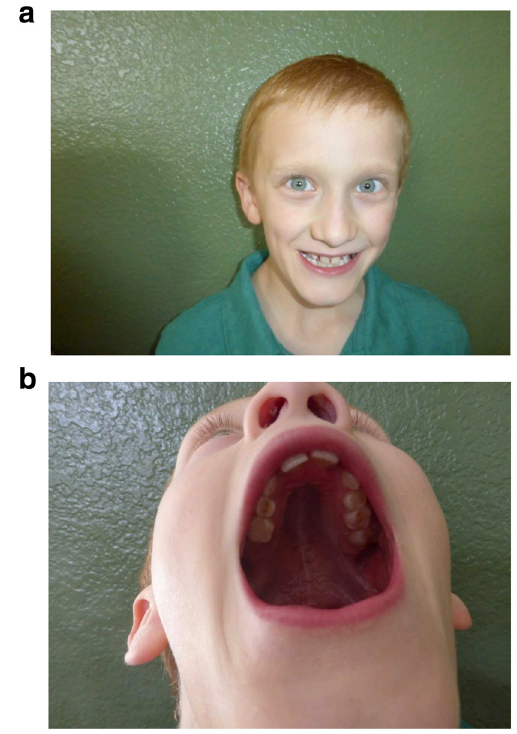
Figure 1. This 7-year-old boy with fragile X syndrome demonstrates a broad forehead ( a ) and a high arched palate ( b ). However, he does not have a long face or prominent ears. He is a high-functioning individual with mosaicism, and DNA testing displays a band at 300 CGG repeats that is methylated as well as bands between 100 and 790 repeats that are unmethylated; overall, 30% of his alleles are unmethylated. He presents with a sequential IQ of 71 and a simultaneous IQ of 83. He has done well with treatment; sertraline has improved his anxiety symptoms, and a long-acting methylphenidate preparation has improved his attention-deficit hyperactivity disorder